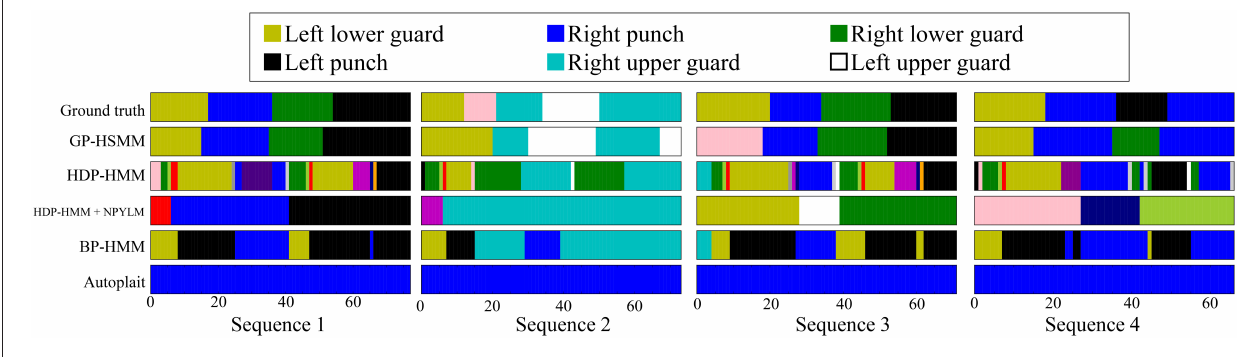
FIGURE 12 | Results of segmentation and classification for each method.